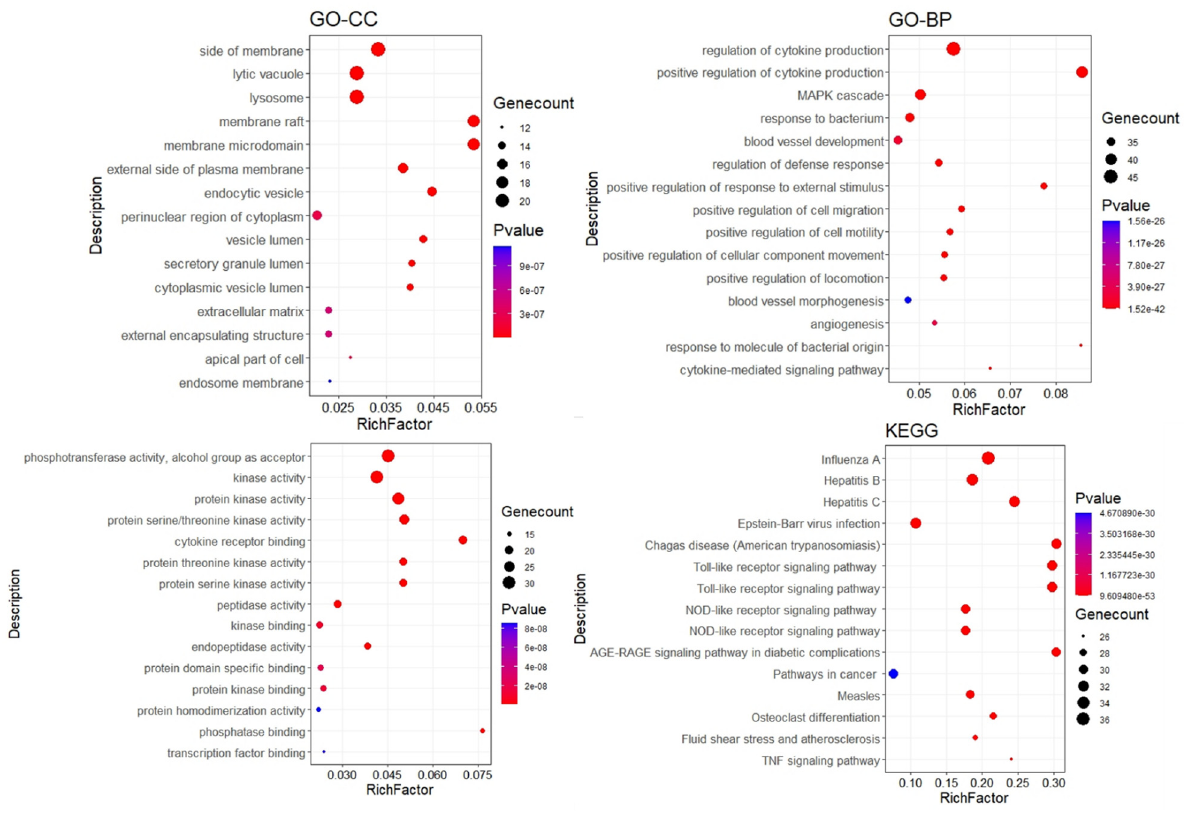
Figure 3: GO and KEGG enrichment analysis of 113 core targets.